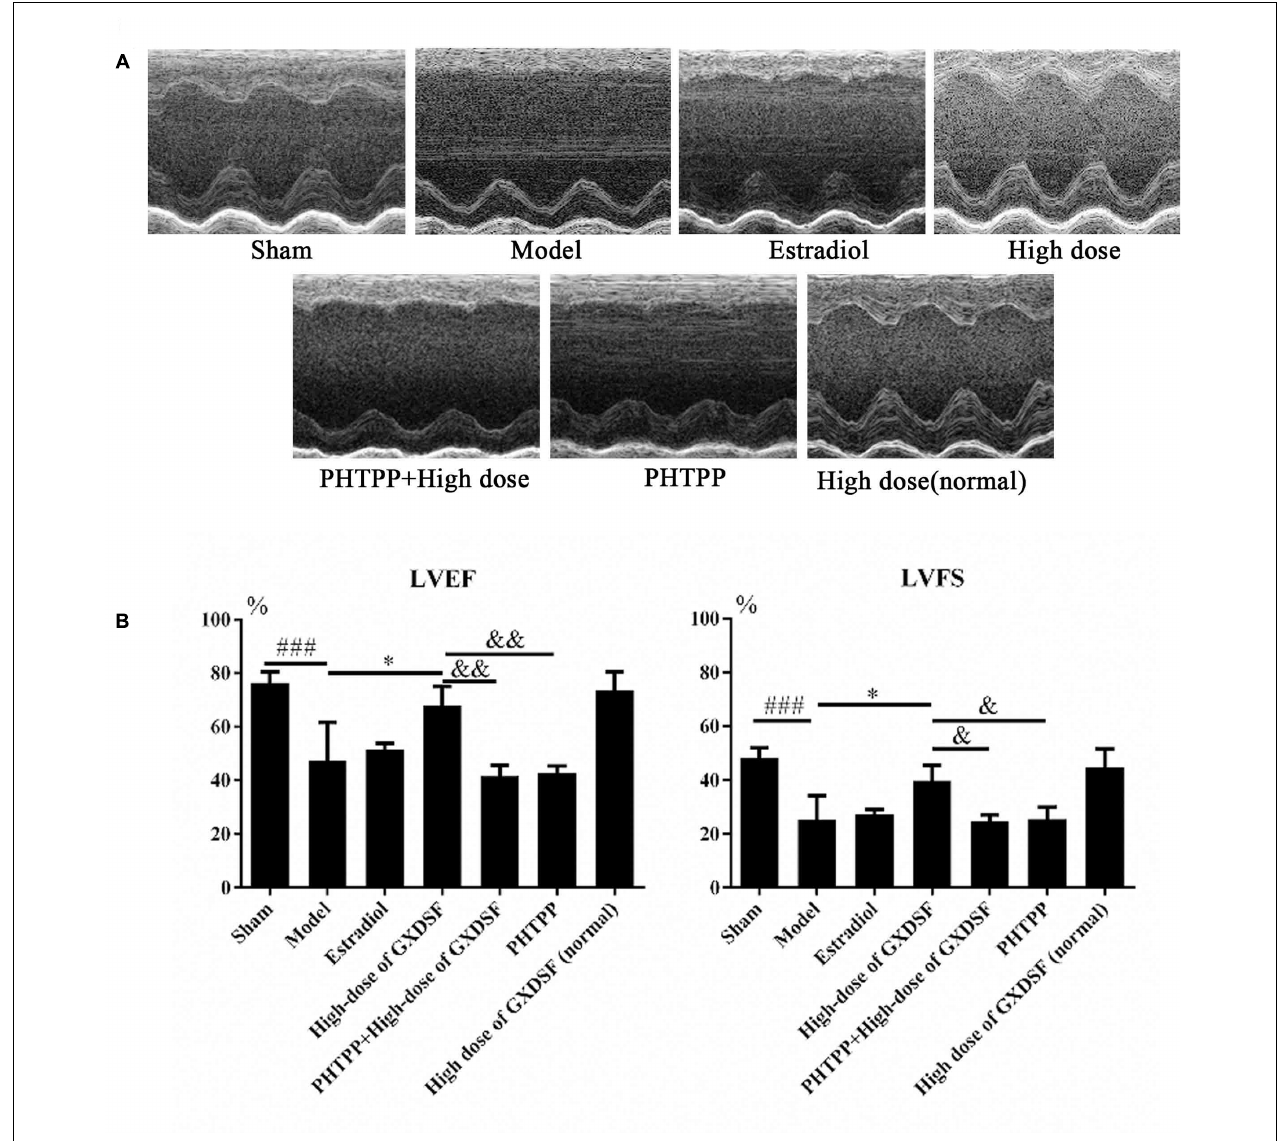
FIGURE 4 | Echocardiogram parameters in MIRI-LVR rats treated with high-dose of GXDSF treated group and PHTPP. The echocardiograms (A) were obtained using the Vevo 770 high-resolution imaging system. LVEF and LVFS (B) data are also shown in bar graphs. Compared with the sham group, ### P < 0.001. Compared with the MIRI-LVR model group: ∗ P < 0.01. Compared with the high-dose of GXDSF treated group: & P < 0.05, && P < 0.01. The data are presented as the mean ± SD ( n = 10 in each